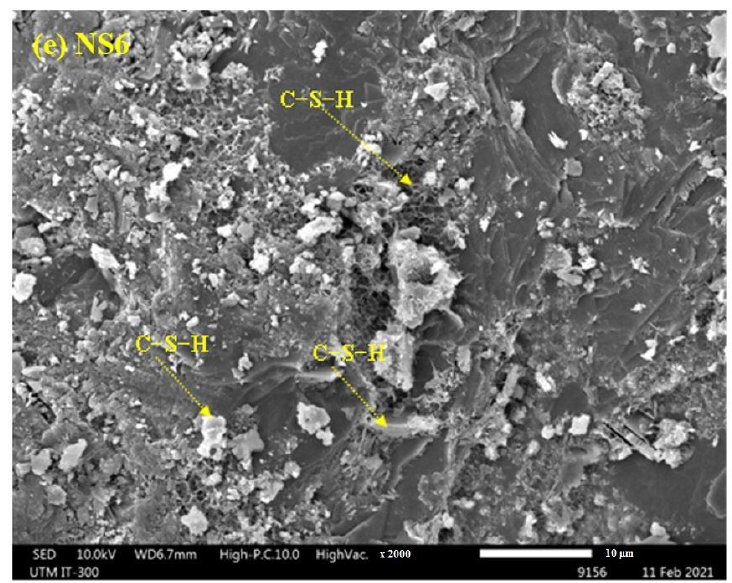
Figure 14. ( a – e ) SEM micrograph of the designed concrete.